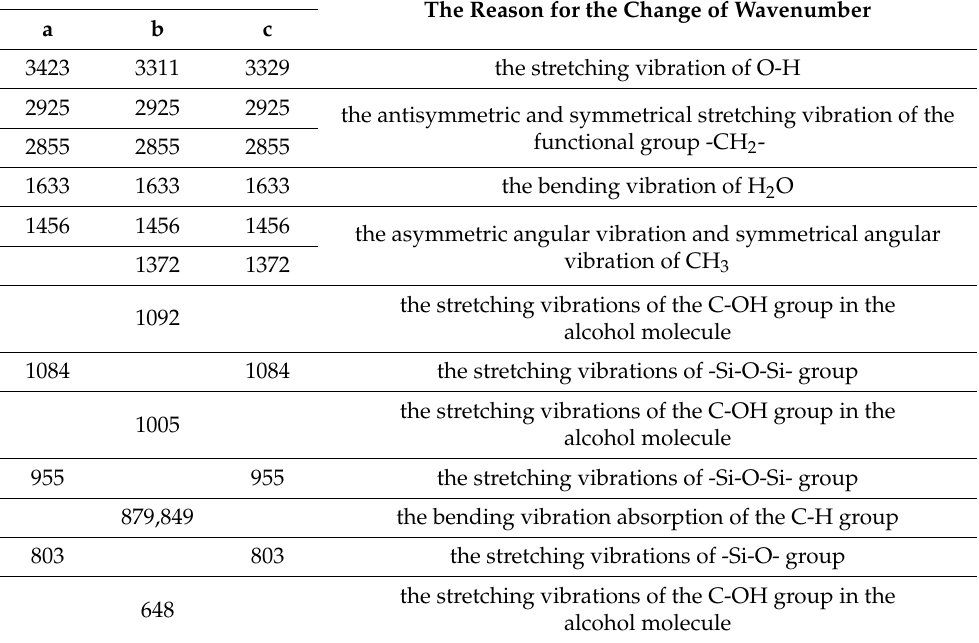
Table 1. Vibrational band shifts and their respective assignments in Fourier transform infrared